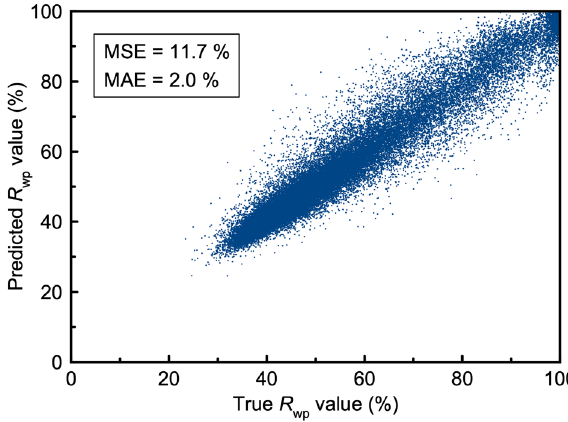
Fig. 4 Predicted R wp values versus true R wp values. R wp values from the fi ts of the catalogue structures to the simulated C 60 dataset, plotted versus the predicted R wp values from the GBDT model from the same structures. The mean squared error (MSE) and the mean absolute error (MAE) are based on all 76,852 predictions in the test set, which are structures the model has not been trained